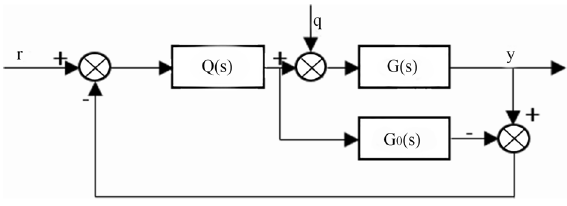
Figure 10. Structure of the internal model control principle.